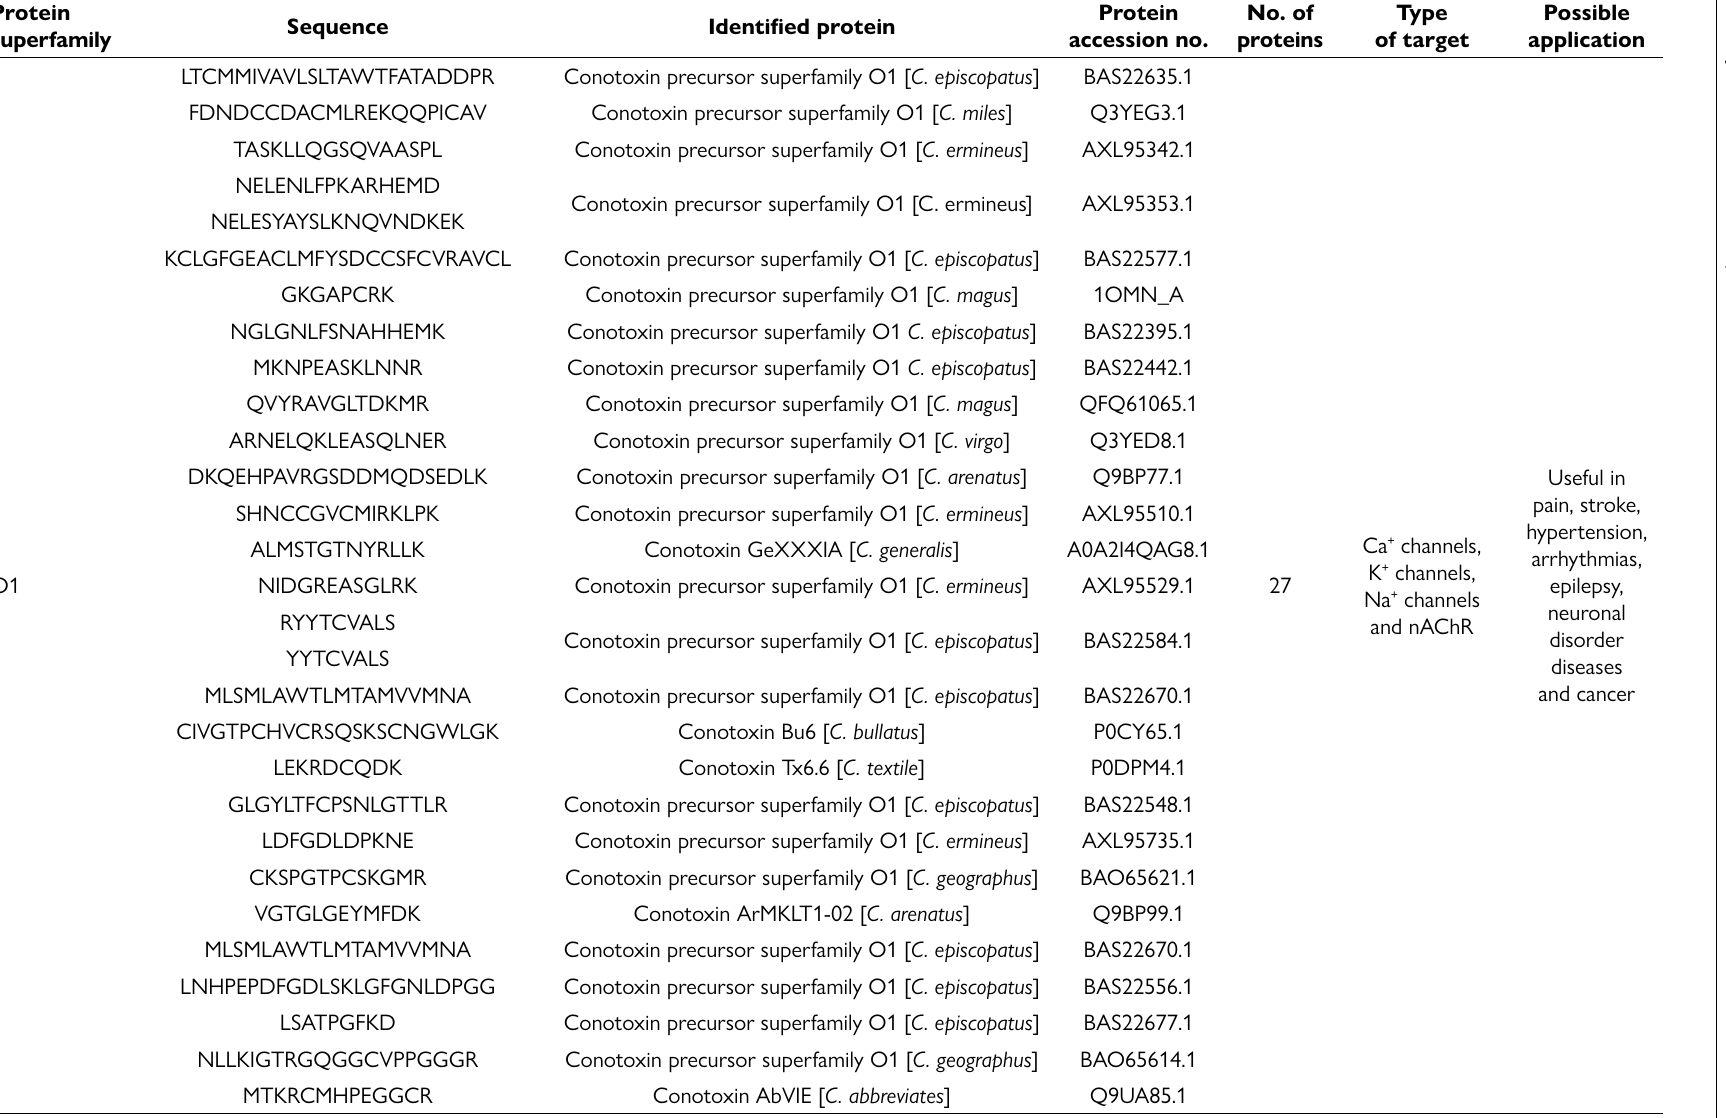
Table 1. Protein